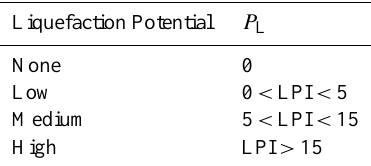
Table 5. Liquefaction potential according to the Liquefaction Po- tential Index ( P L ) (MERM,